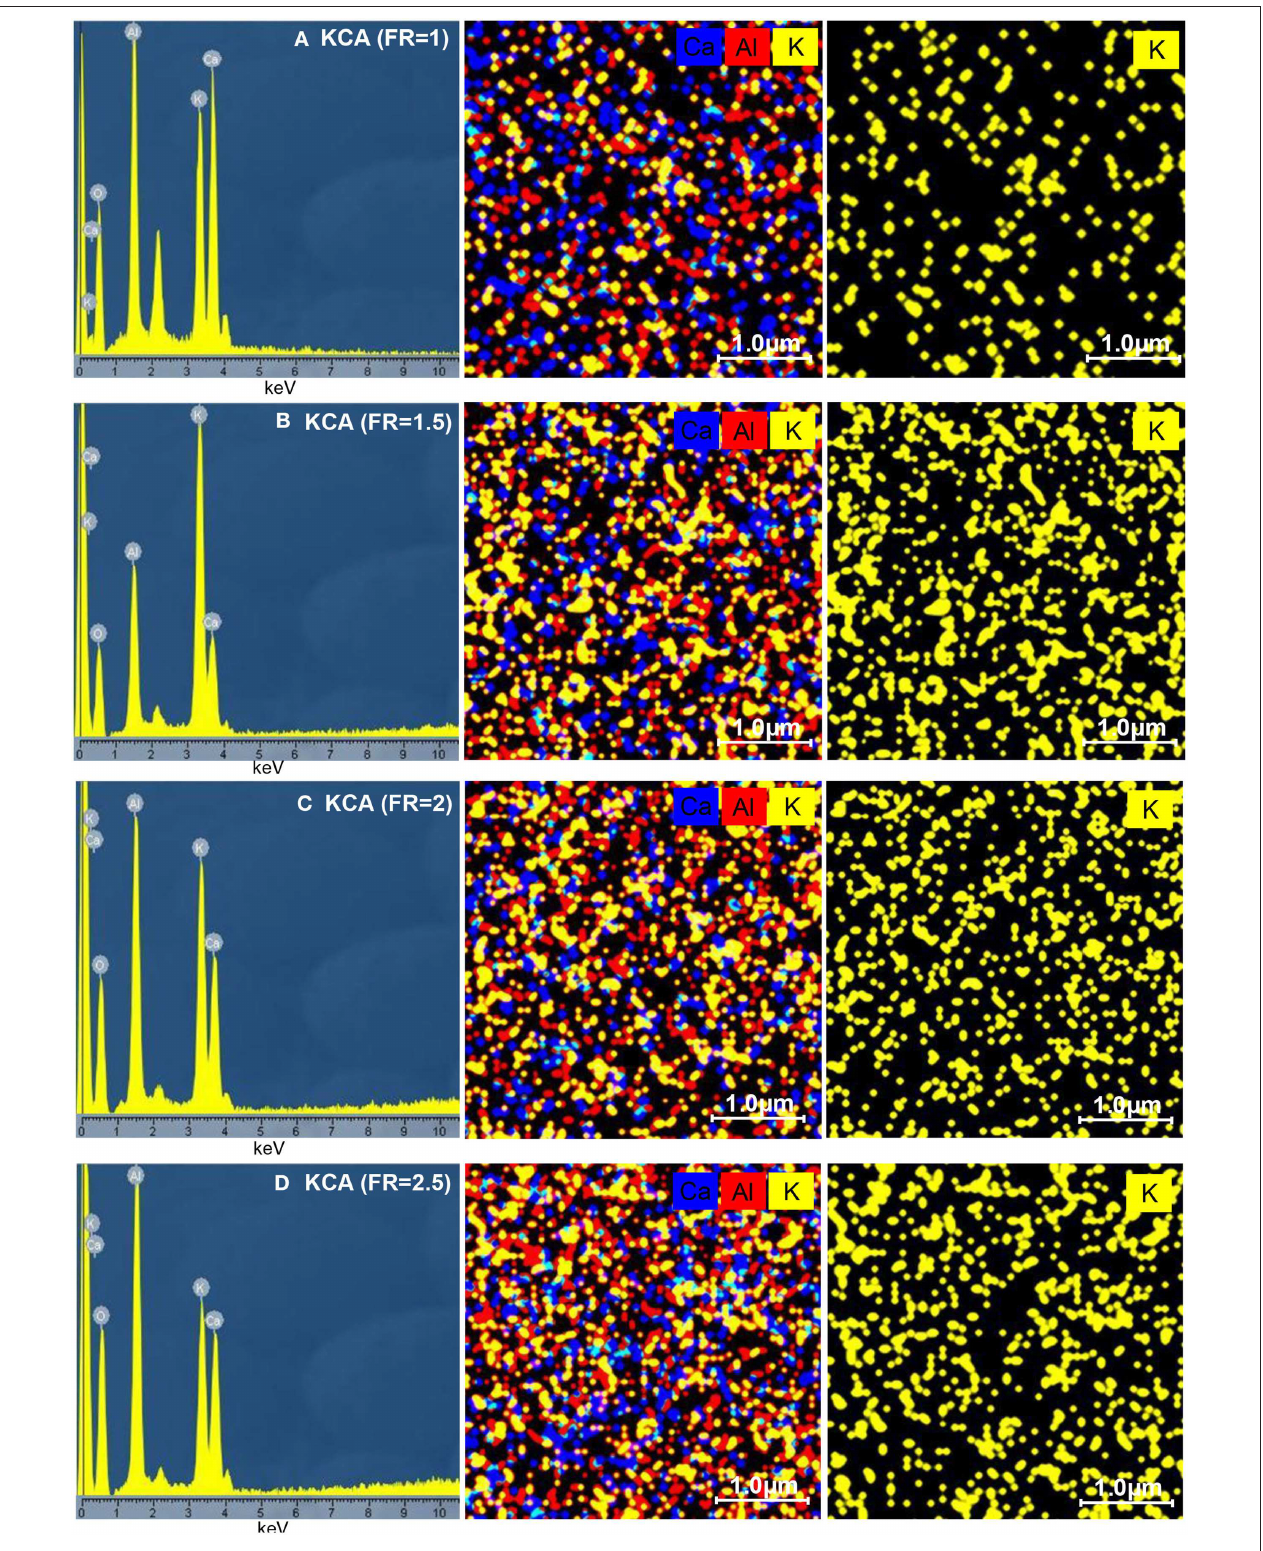
FIGURE 6 | EDX analysis of synthesized KOH/Ca 12 Al 14 O 33 nanostructured catalysts with various fuel ratios: (A) KCA(FR = 1), (B) KCA(FR = 1.5), (C) KCA(FR = 2), and (D) KCA(FR = 2.5).